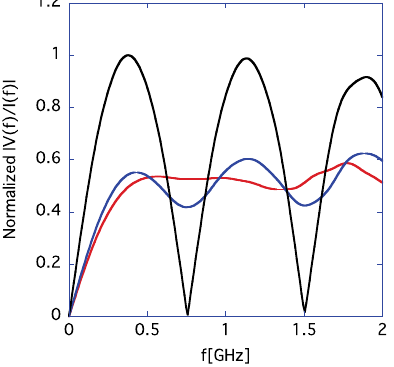
FIG. 10. The black, the blue and the red lines show results for the electrode shapes; the rectangular one, the exponential one, and the polynomial one, respectively, where one end (upstream side) of the electrode is terminated with a 50 Ω resistor (lumped elements) behind the feedthrough. All results are divided by the peak value at 0.38 GHz for the rectangular